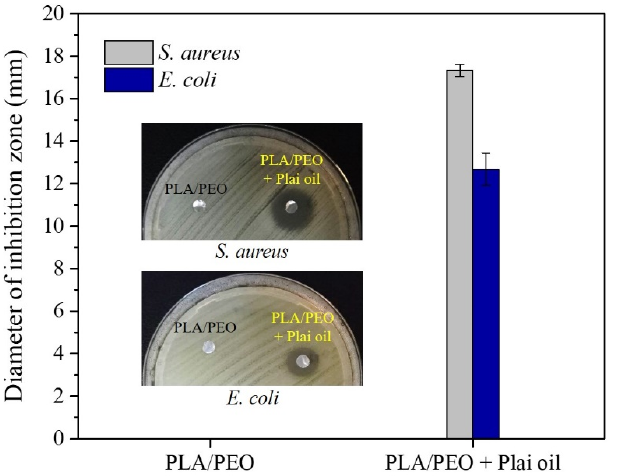
Figure 6. Antibacterial activity of PLA/PEO and essential oil-loaded PLA/PEO fiber blend mem- branes against S. aureus and E. coli .